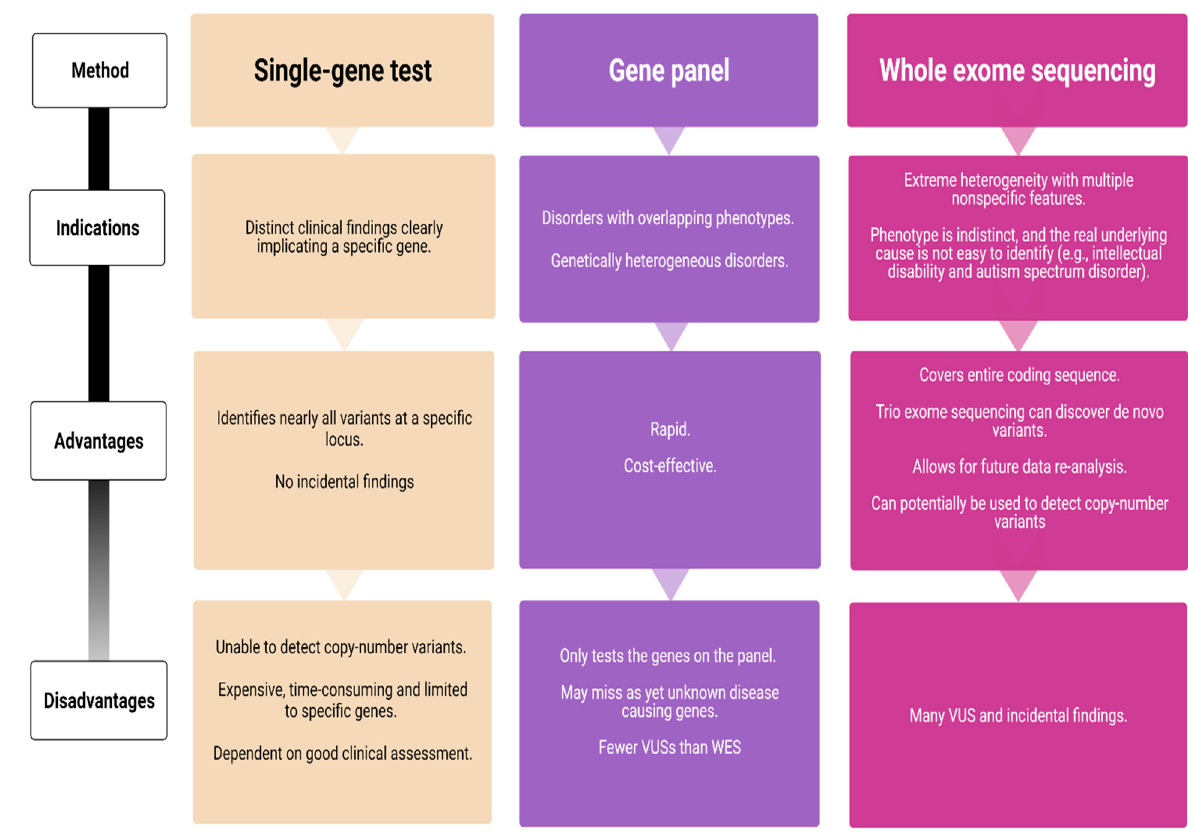
Figure 1. Comparison of genetic testing strategies (VUS = variant of unknown significance; WES = whole exome sequenc- ing).